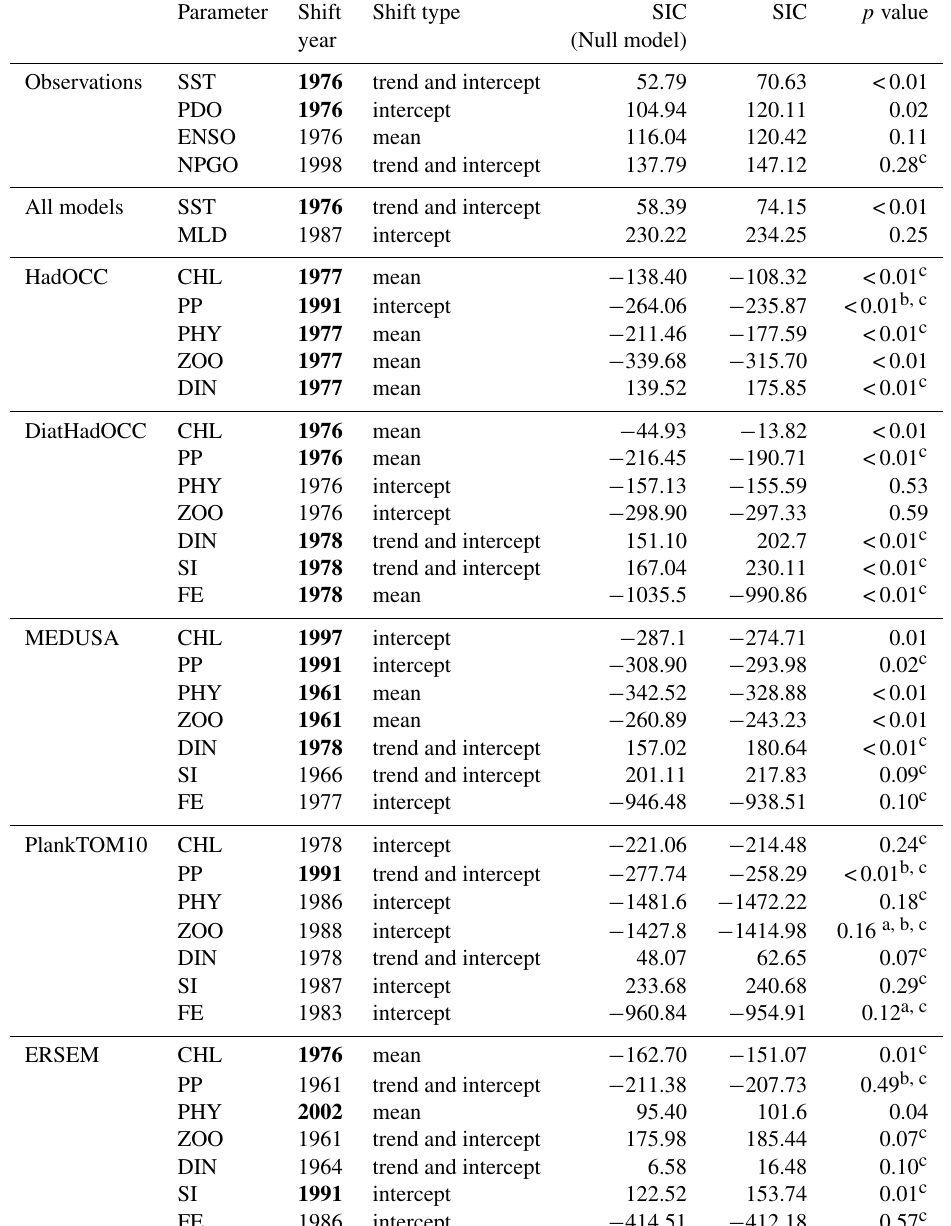
Table B1. Results from change-point detection analysis for all observational and modelled time series. Years in bold have a significant shift ( p